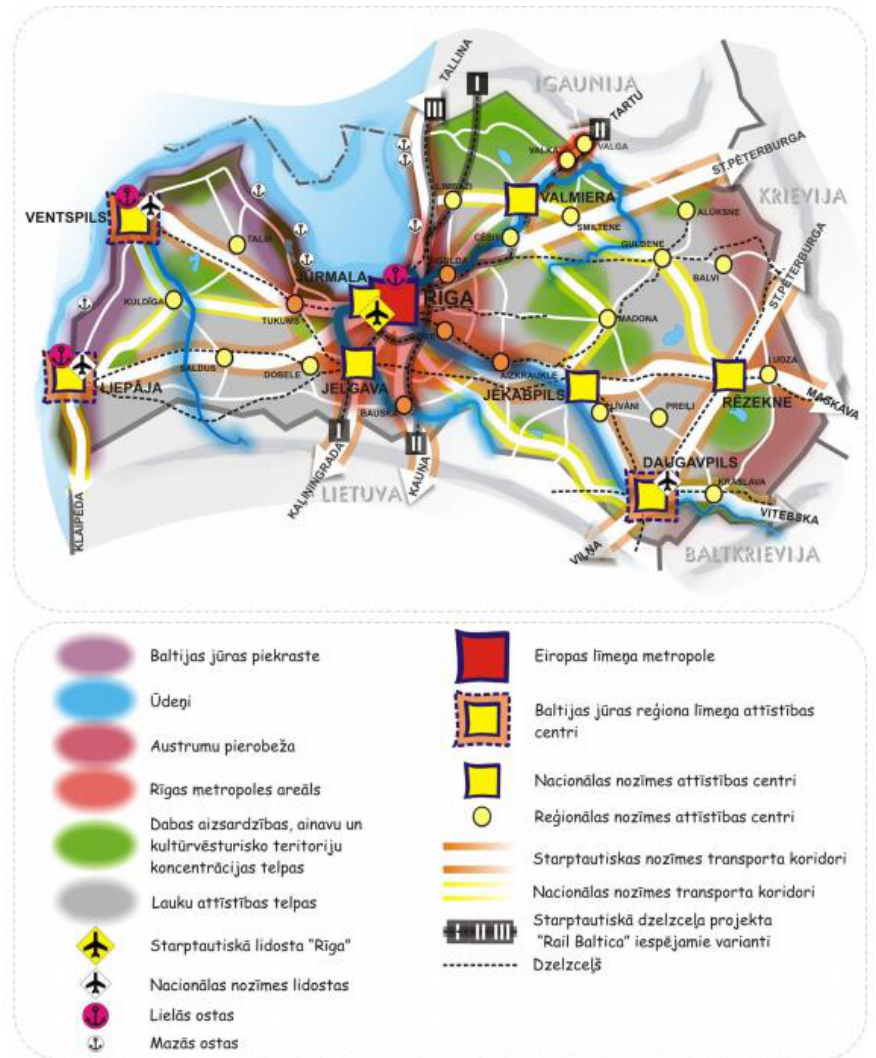
Fig. 1. Future spatial structure of Latvia (Saeima of the Republic of Latvia,